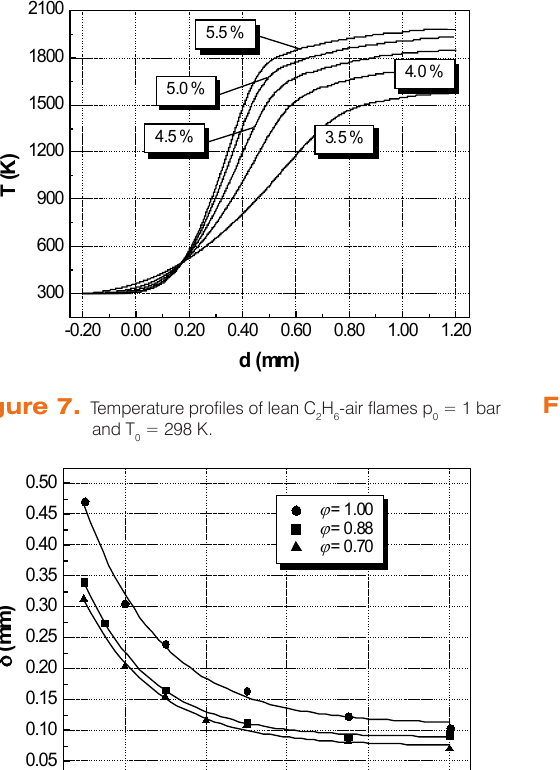
H -air mixtures. (a) C 2 6